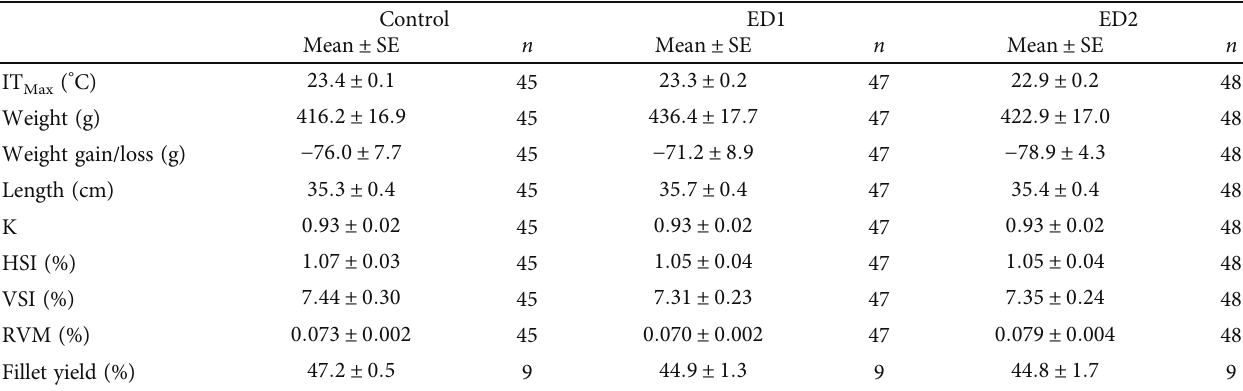
Table 6: Morphological and production metrics, and the incremental thermal maximum (IT succumbed to the increasing temperature protocol. Fish were fed either the control diet, experimental diet # 1 (ED1), or experimental diet # 2 (ED2).